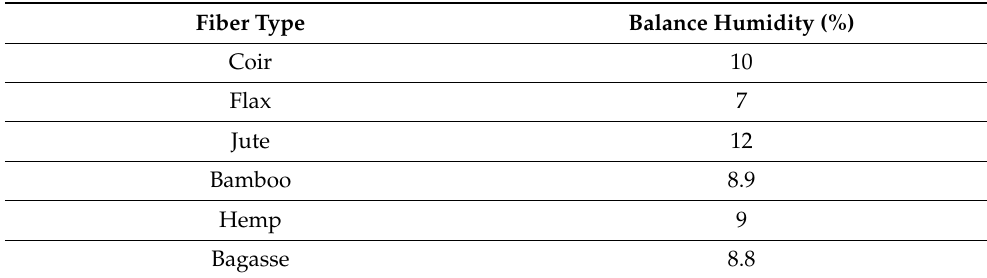
Table 3. Moisture balance of natural